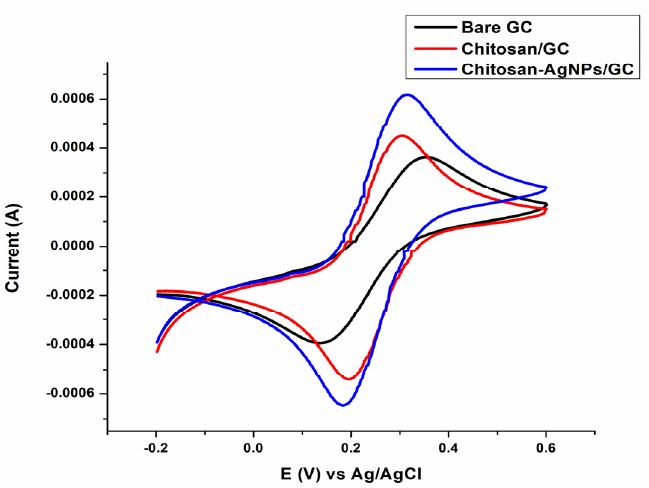
Figure 5. Cyclic voltammograms of the GC (Bare glassy carbon), CH/GC (chitosan modified glassy carbon) and CH-AgNPs/GC (chitosan-Silver nanoparticles modified glassy carbon) in 0.1 M ferricy- anide solution in 10 mL of 1 M KCl with a scan rate of 1 V/s.